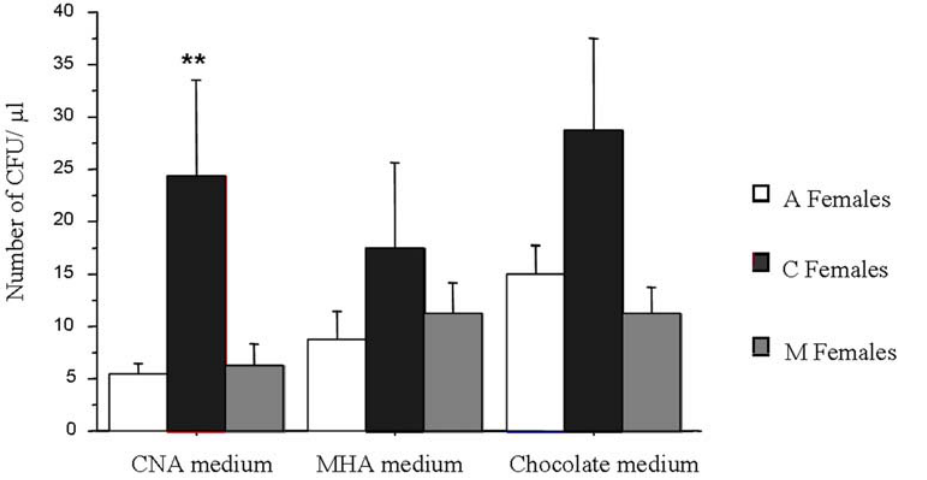
Figure 5. Effect of Wolbachia on CFUs obtained from haemolymph samples. Haemolymph samples from A. vulgare females infected or not by Wolbachia were streaked onto several agar media (CNA, MHA and Chocolate). On CNA [selective medium for Gram ( + ) bacteria], the mean number of CFUs obtained for haemolymph samples from C females was significantly higher than in A females or M females.